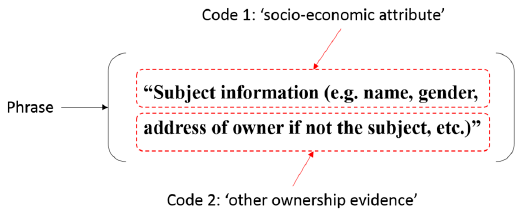
Figure 2. Coding example. Figure 2. Coding